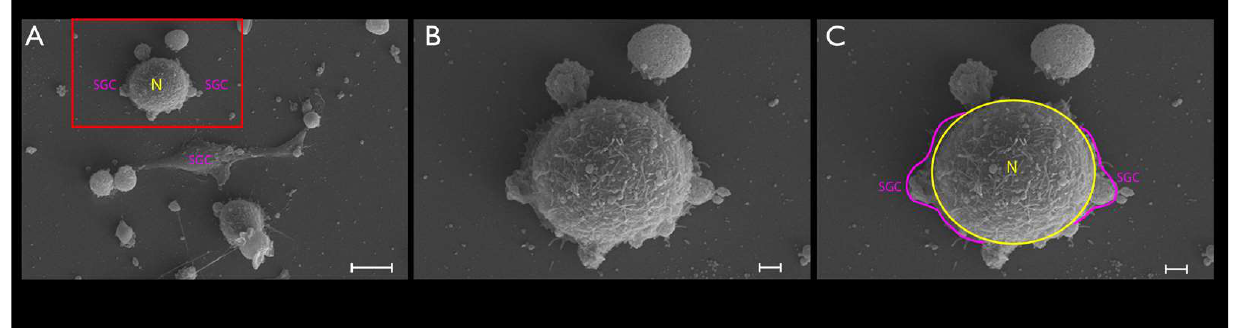
Figure 3. The same pattern found with phase-contrast microscopy was demonstrated with the SEM of the TG cultures ( A – C ). To obtain a better visualization, SGCs were highlighted in pink, and the neurons in yellow. SCGs lost their proximity to the neurons at this stage. Scale bars represent 10 µm in ( A ) and 2 µm in ( B , C ).